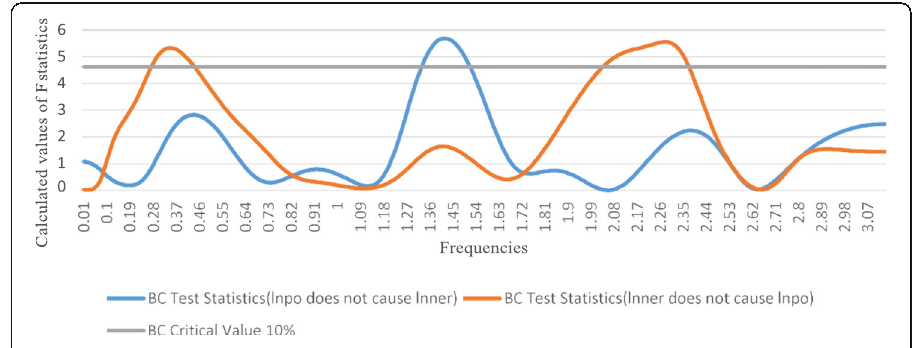
Fig. 6 The frequency domain causality between nominal exchange rate and palm oil price